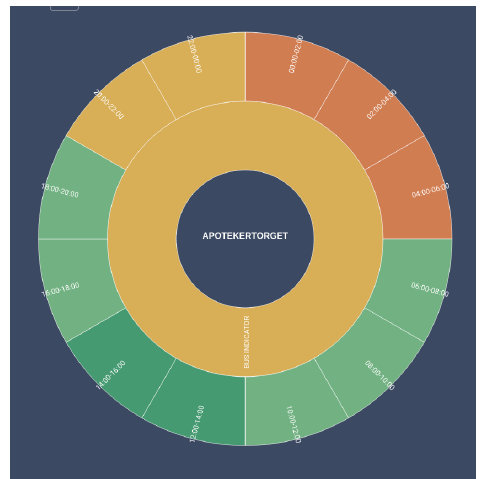
Figure 12. Diagram of Apotekertorget, ˚Alesund, Norway.